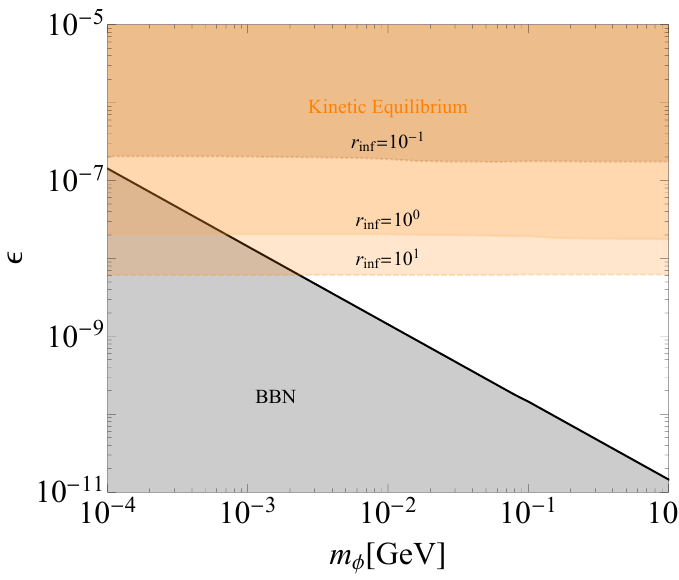
Figure 2 . Constraints on the φ versus (cid:15) parameter space. The gray shaded region indicates where decays occur after neutrino decoupling and is excluded by BBN. The shaded region above (below) the orange dashed curve indicates that the decays of φ occur in (out) of